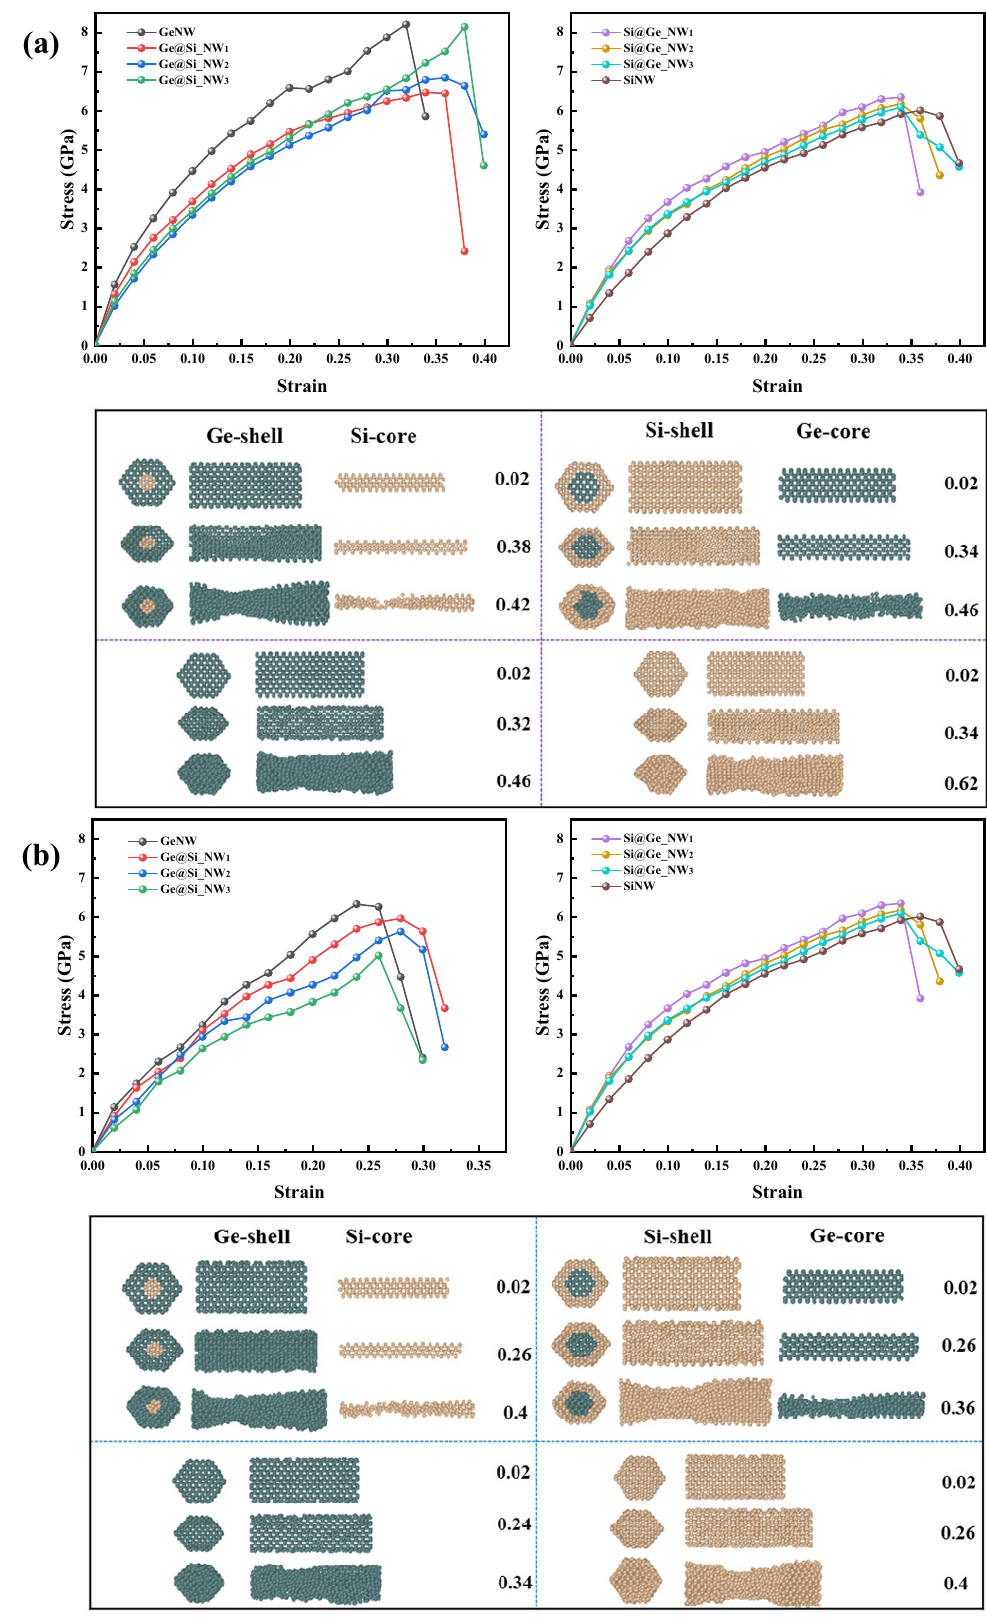
Figure 4. The stress–strain curves and packing images of Ge@Si and Si@Ge nanowires with different core–shell ratios at different temperatures during stretching processes: ( a ) 300 K; ( b ) 800 K.